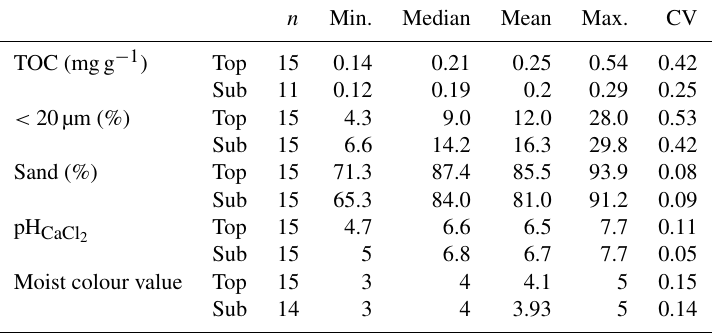
Table 7. Summary of the chemical and physical characteristics of topsoil (5–15cm) and subsoil (25–35cm) layers of the studied omutunda soil profiles. CV: coefficient of